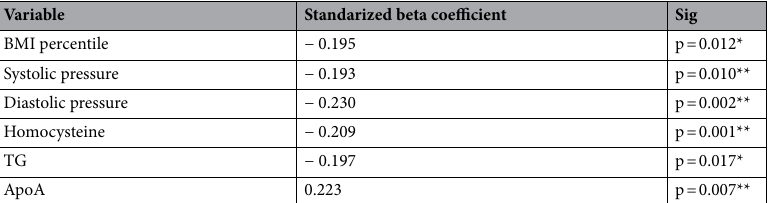
Systolic pressure under 85th percentile